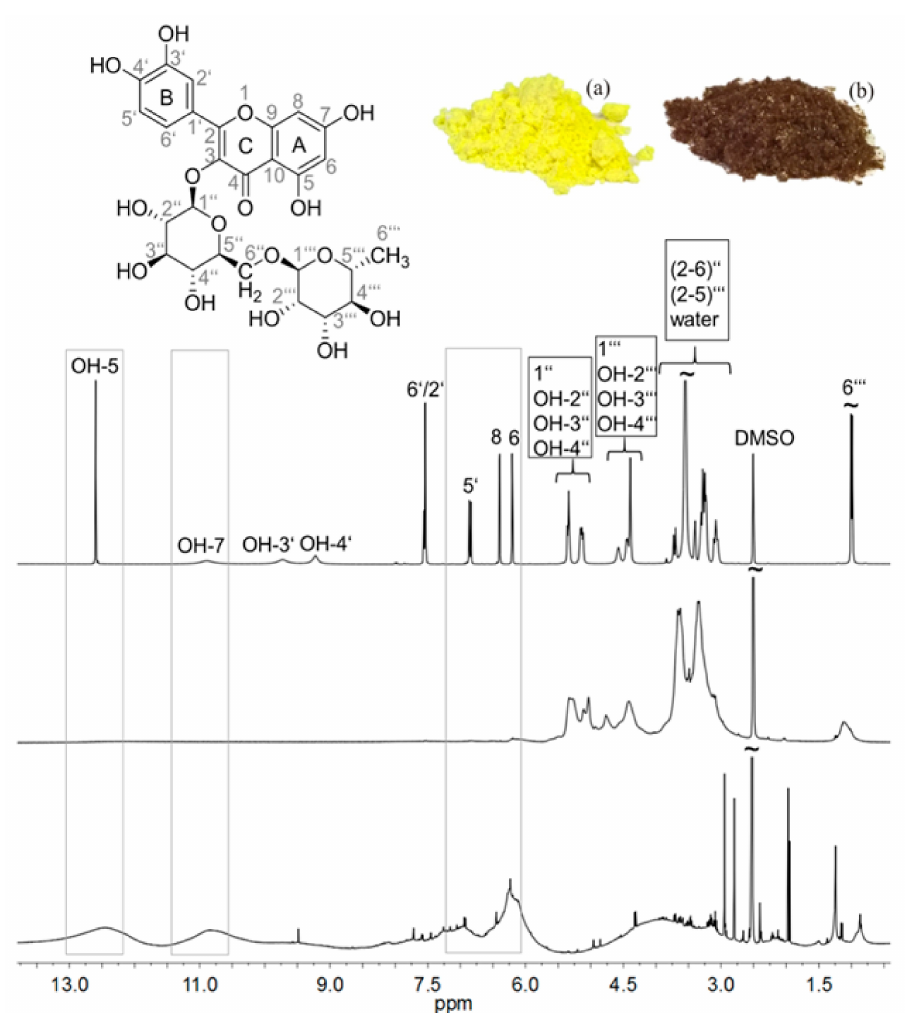
Figure 1. 1 H NMR spectra of rutin (RU; top ), PR ( centre ), and polyquercetin (PQ; bottom ) recorded at 400 Mhz in DMSO-d 6 and digital image of RU ( a ) and PR ( b